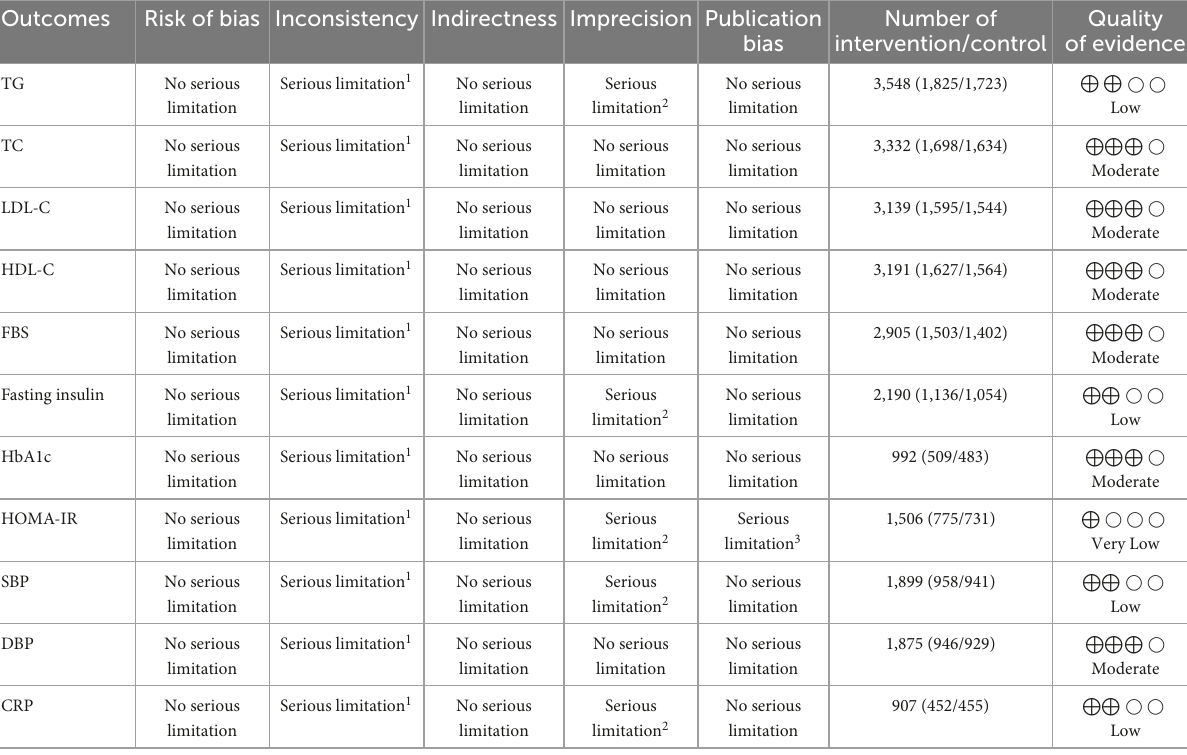
TABLE 4 GRADE profile of green tea extract supplementation for some cardiovascular risk factors in adults.